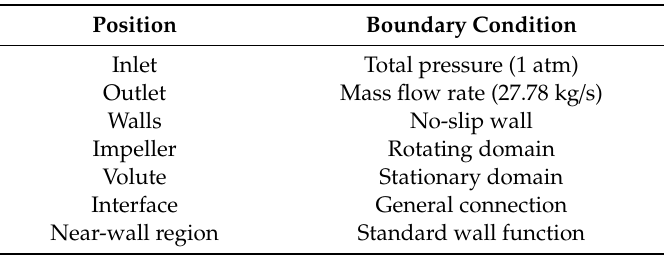
Table 4. Boundary condition